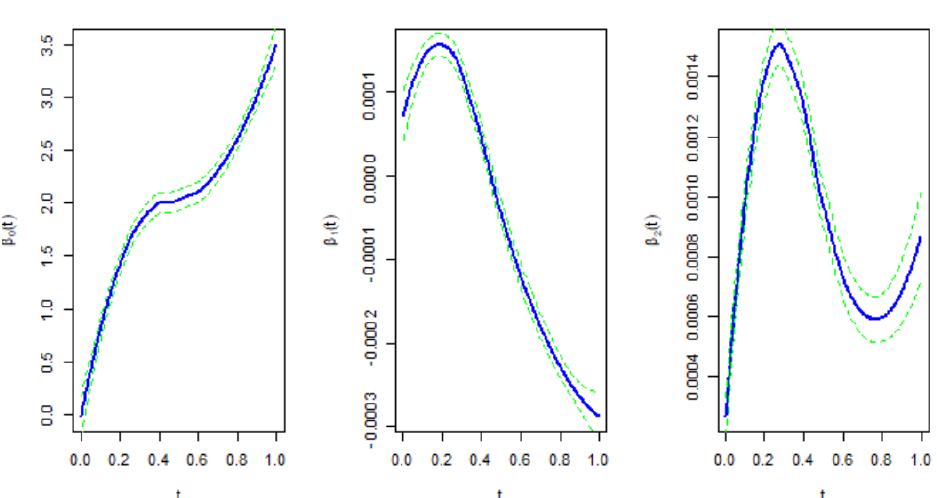
Figure 7. The regression coefficient functions estimated by the proposed RKHS method. Solid blue line: estimated curve; dotted lower and upper green lines: 95% confidence bands. The time t has been scaled to the interval [ 0,1 ]